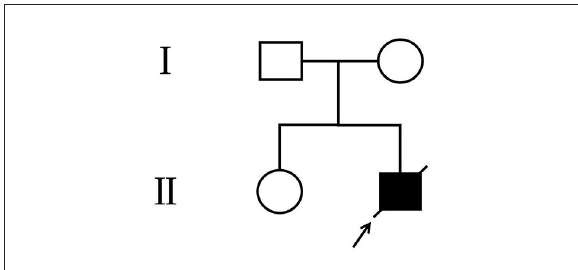
FIGURE1 Pedigree of the family. The arrow denotes the proband and the hollow symbols represent the unaffected members.